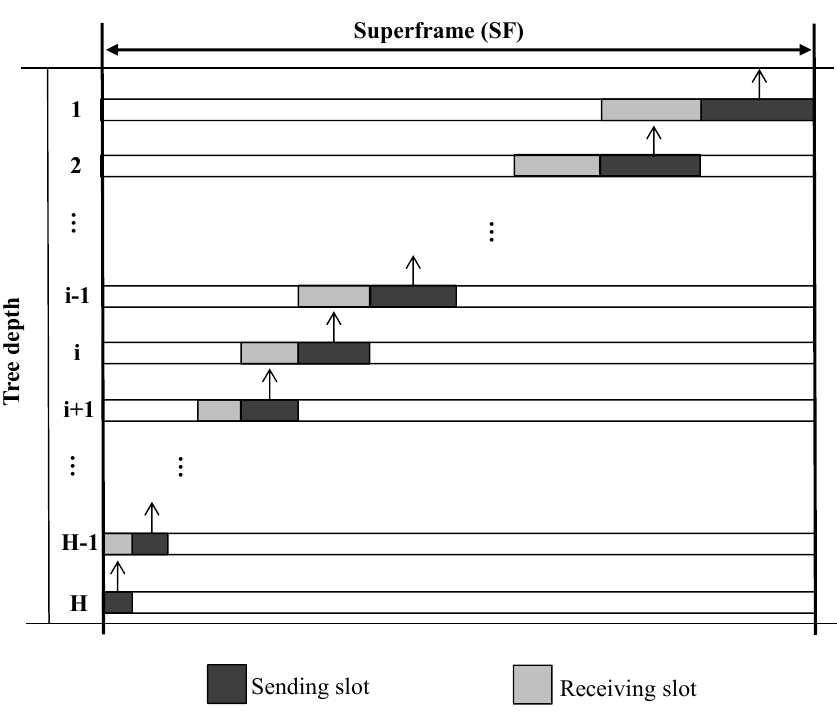
Figure 5. An illustration of a slot scheduling.